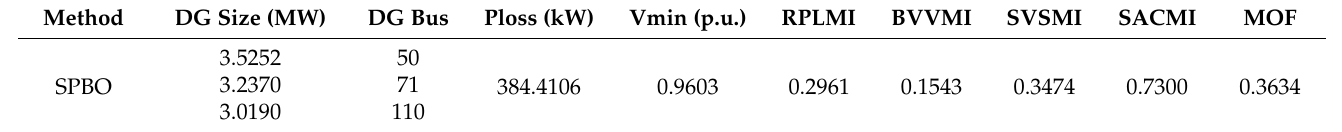
Table 8. Comparison of results for exclusive GT-DG allocation (case-4) for 118-bus test